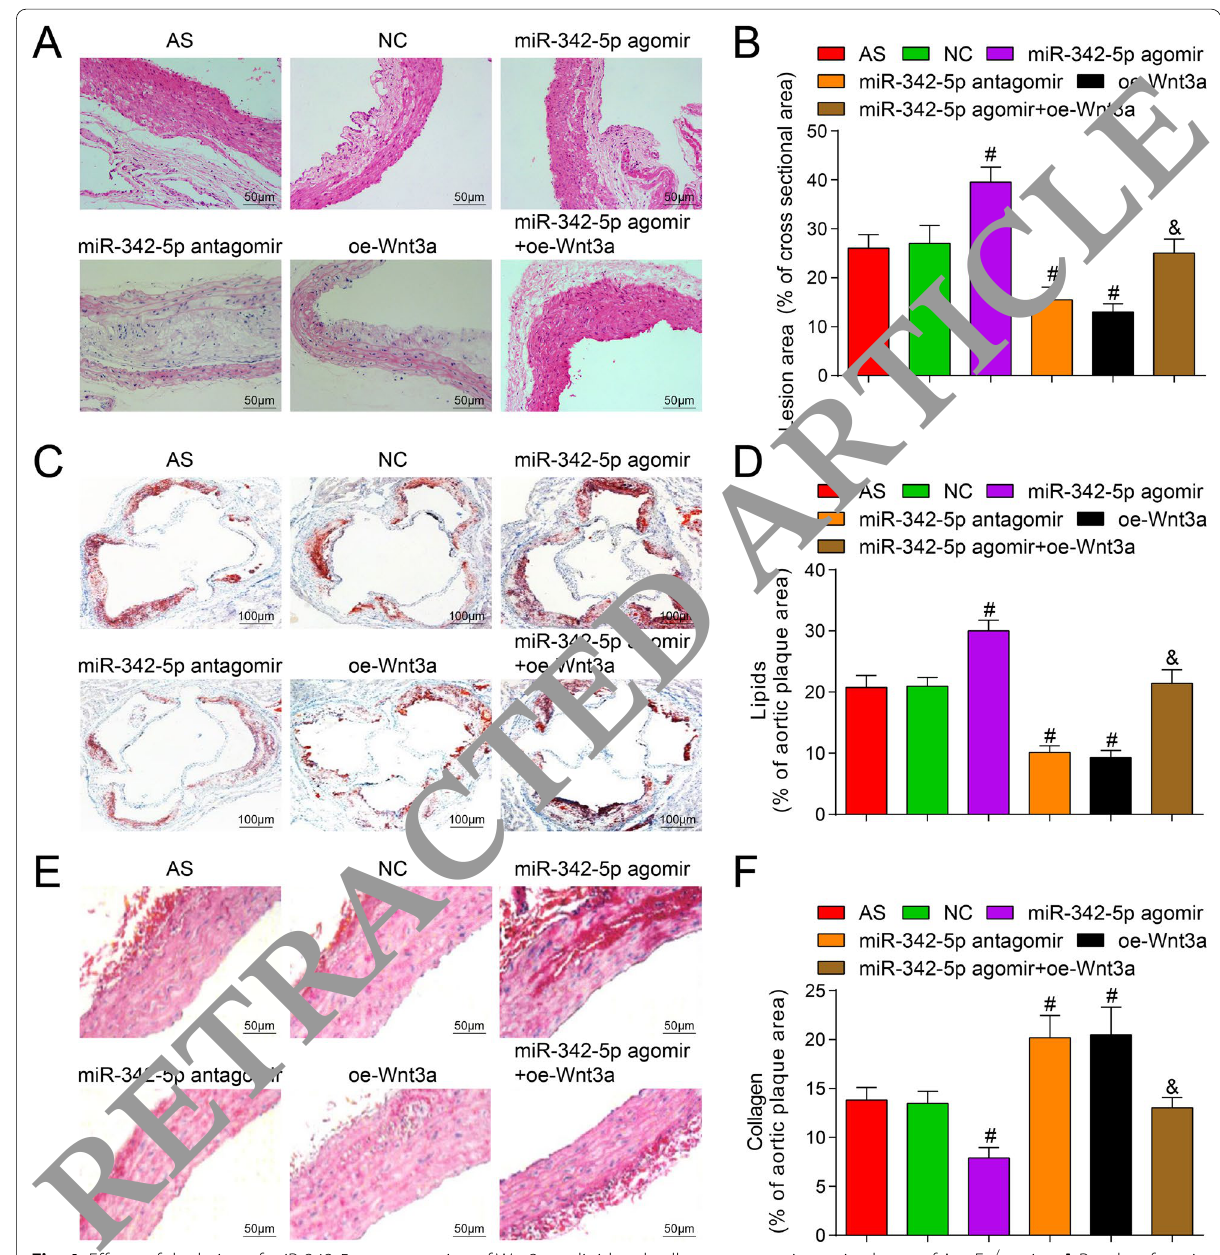
Fig. 4 Effects of depletion of miR-342-5p or restoration of Wnt3a on lipid and collagen content in aortic plaque of ApoE − / − mice. A Results of aortic HE staining in mice (scale bar: 50 μm). B Comparison of aortic plaque area in each group of mice. C Results of aortic Oil Red O staining in all groups of mice (scale bar: 100 μm). D Comparison of lipid content in aortic tissue of mice. E Results of aortic Sirius red staining in each group of mice (scale bar: 50 μm). F Comparison of collagen contents in aortic tissues of mice. n 12. # P < 0.05 vs. the NC group. & P < 0.05 vs. the miR-342-5p agomir = group. Measurement data were indicated as mean standard deviation. Comparisons among multiple groups were assessed by one-way ANOVA ± followed by Tukey’s multiple comparisons test. AS, atherosclerosis; NC, negative